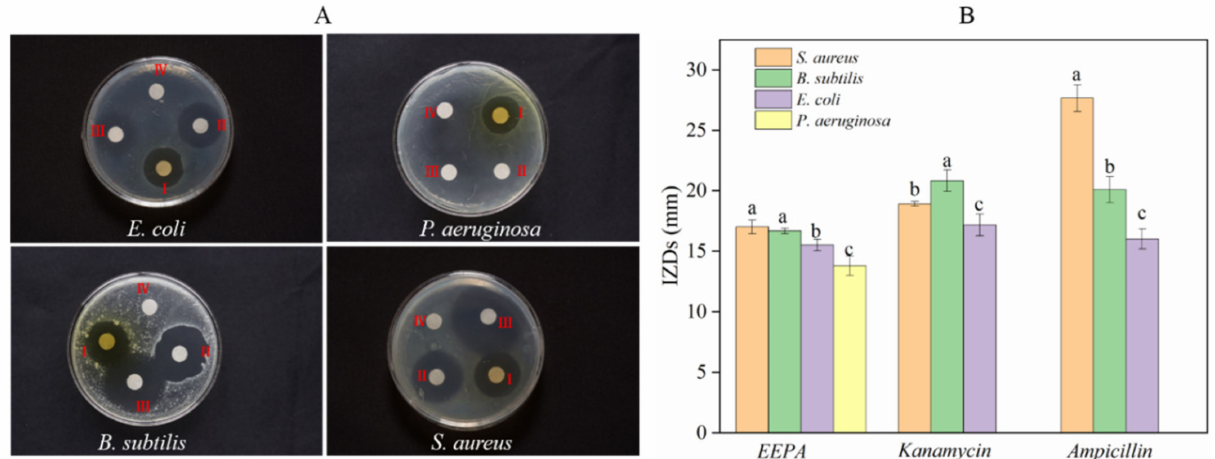
Figure 3. Antibacterial activity assay of the ethanol extract from pericarp of A. trifoliata . ( A ) Bac- teriostatic circle: (I) 30 ug of EEPA; (II) 5.0 ug of kanamycin; (III) 5.0 ug of ampicillin; (IV) sterile water. These experiments were performed in triplicate. ( B ) The inhibition zone diameter.